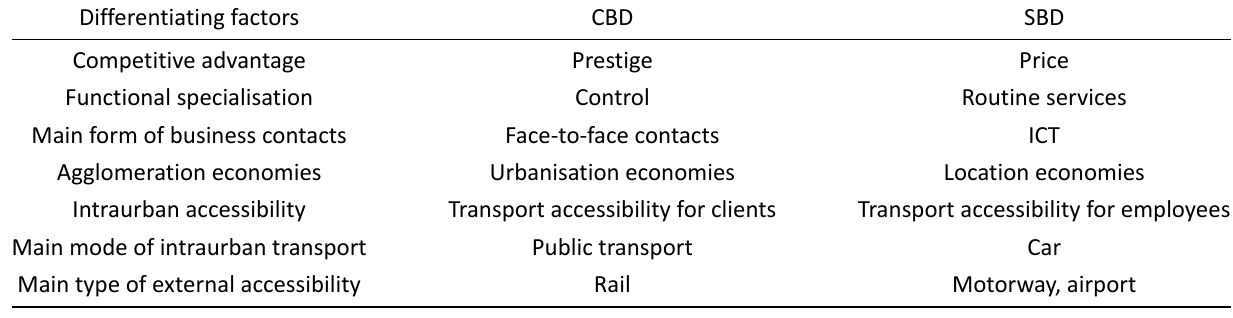
Table 1. Key differences between CBD and SBD location/attractiveness factors based on the literature review. Differentiating